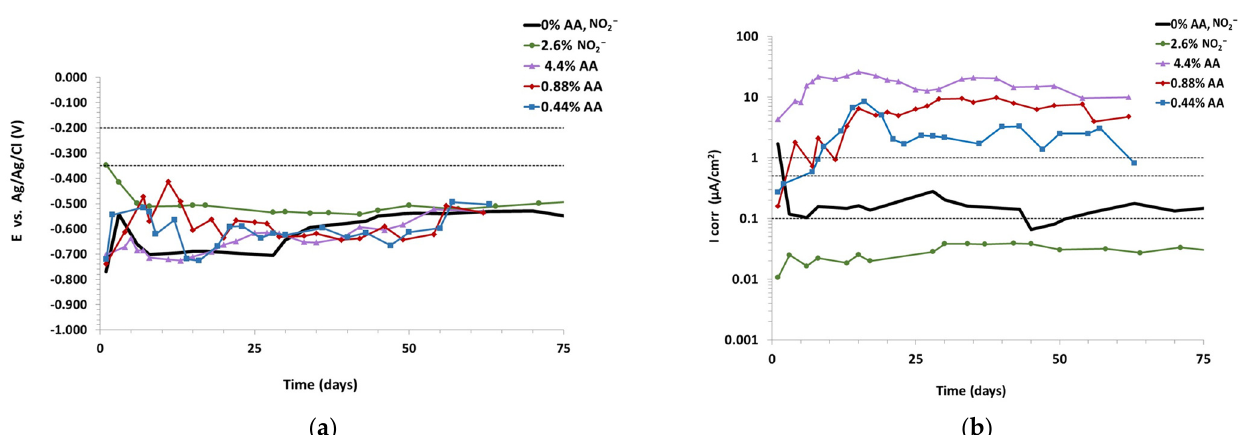
Figure 1. Chloride-contaminated mortars with 4.4, 0.88 and 0.44% of AA and 2.6% of NO 2 − ( a ) OCP, ( b ) Icorr.